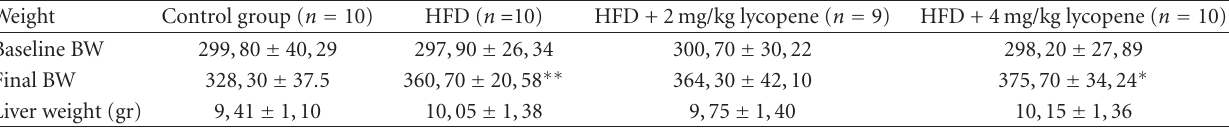
Table 1: The e ff ects of lycopene supplementation on body weight and liver weight in groups.